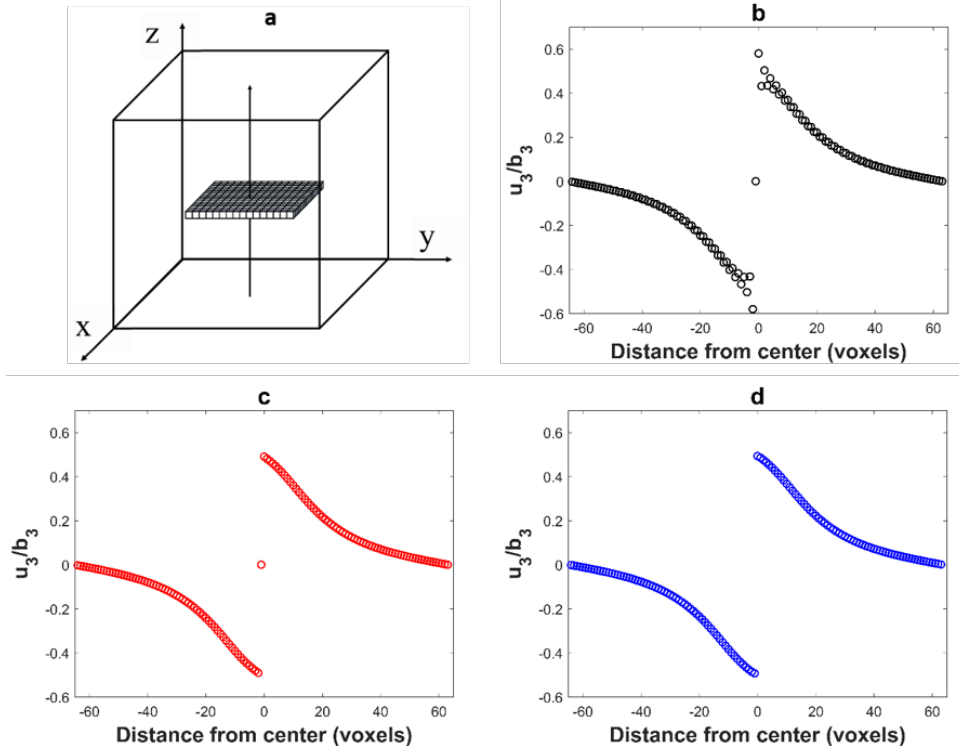
Figure 1. ( a ) Simulation of a square dislocation loop in plane (001) by a platelet with eigenstrain; ( b ) component 𝑢 3 of the displacement field (normalized by 𝑏 3 ) along the z axis (arrow) computed with the Green operator 𝑩 and showing spurious oscillations; ( c ) same component 𝑢 3 computed with 𝑩 ′ . The displacement at voxel (64,64,64) is zero in the center of the inclusion ( c ) and 𝑏 3 2⁄ on its surface; ( d ) same component 𝑢 3 computed with 𝑩 ′′ .